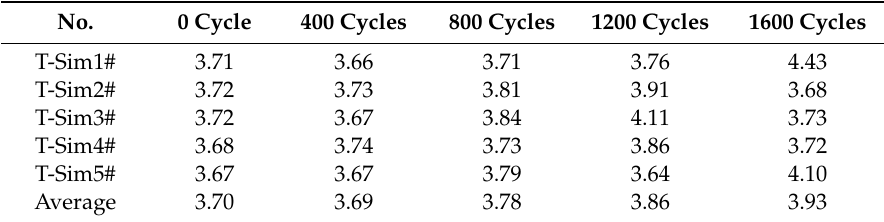
Table 8. The simulated temperature di ff erences of solder